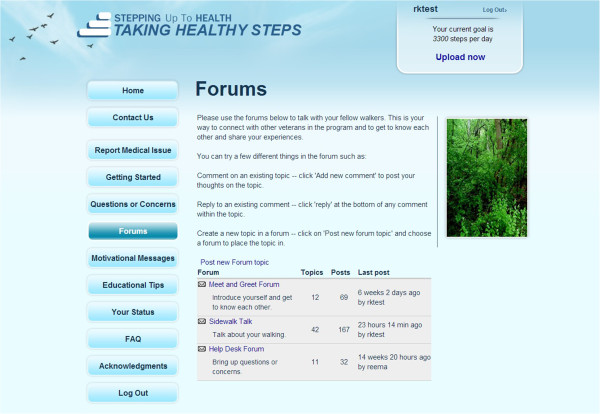
Example of the online communities and forums for participants in Taking Healthy Steps.